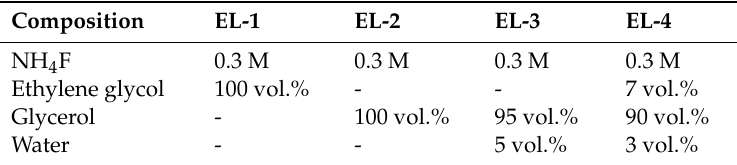
Table 1. Compositions of di ff erent electrolytes used in this work. Composition EL-1 EL-2 EL-3 EL-4 NH 4 F 0.3 M 0.3 M 0.3 M 0.3 M Ethylene glycol 100 vol.% - - 7 vol.% Glycerol - 100 vol.% 95 vol.% 90 vol.% Water - - 5 vol.% 3